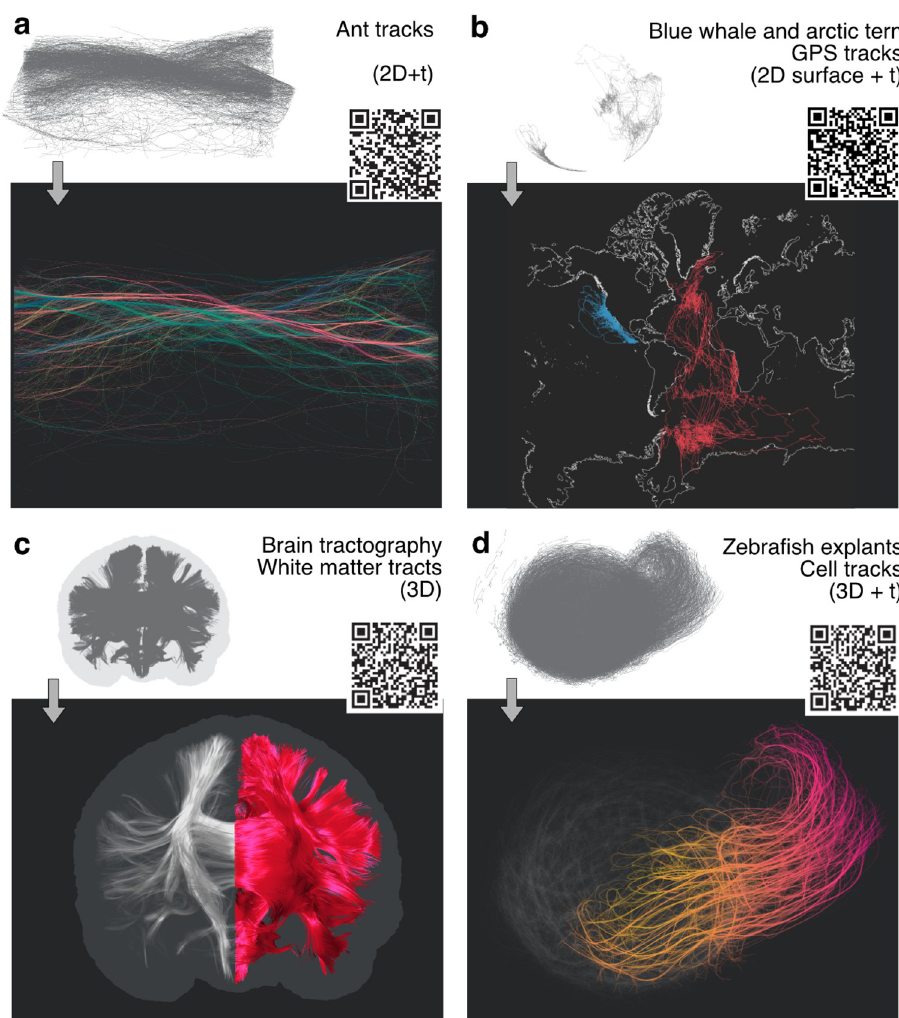
Fig 3. Sharable interactive visualisation packets for a multitude of applications ranging across a variety of sciences. The user can combine the visualisation methods, annotations, and camera motion paths in a scheduled tour that can be shared by a custom URL or QR code generated directly in the browser interface. Panels (a)-(d) demonstrate use cases for real-world datasets with different characteristics and dimensionality. (a) Ant trails (2D+t) from [18]. Bundling and colour-coding (spatial orientation by mapping (x,y,z) to (R,G,B) values) indicate the major trails running in opposing directions. (b) GPS Animal tracking data for two species (blue whales [19]—blue and arctic tern [20]— red) shown on a Mercator projection of the earth’s surface. For a better orientation, the outline of the continents is included as axes into the visualisation that dynamically adapt to the projections and viewpoint changes (2D surface data + t). (c) Brain tractography data showing major white matter connectivity from diffusion MRI (3D). The spatial selection highlights the left hemisphere, while anatomical context is provided by the outline of the entire brain (from mesh data) and the defocused tracts of the right hemisphere. (d) Cell movements during the elongation process of zebrafish blastoderm explants (3D+t) [21]. Bundling, colour coding, and spatial selection highlight collective cell movements as the explant starts elongating, focusing on a subpopulation of cells driving this process. The colour code shows time from early (yellow) to late (red) for selected tracks.